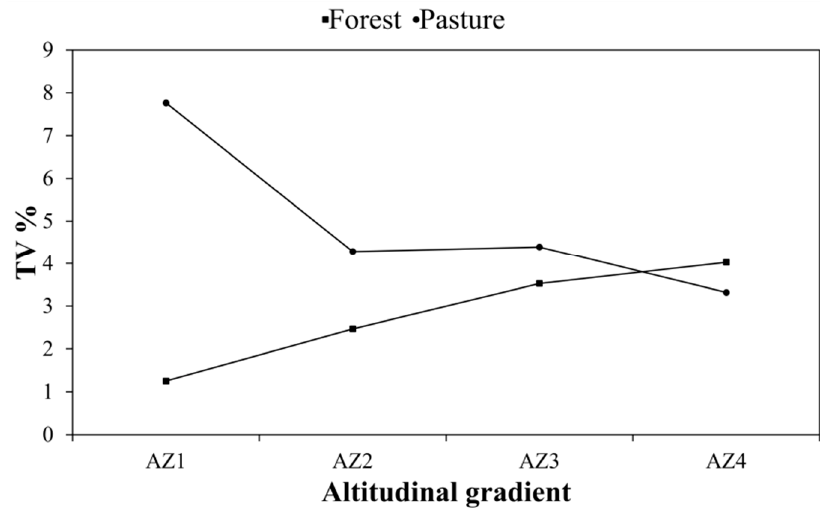
Figure 5. TV% along altitudinal gradient in Piemonte region. Forests class shows an increasing trend